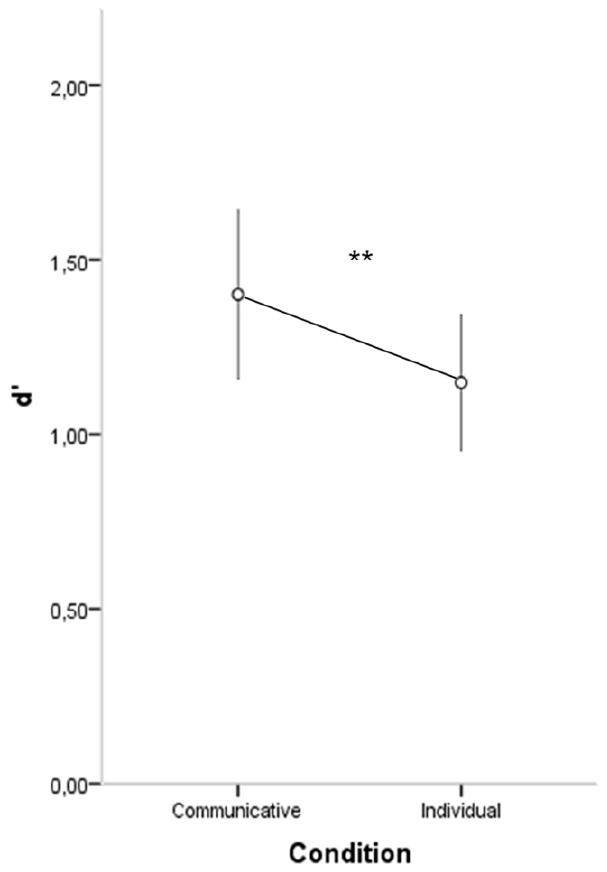
Figure 2. Sensitivity (d’) in the two experimental conditions. Error bars represents 95% confidence